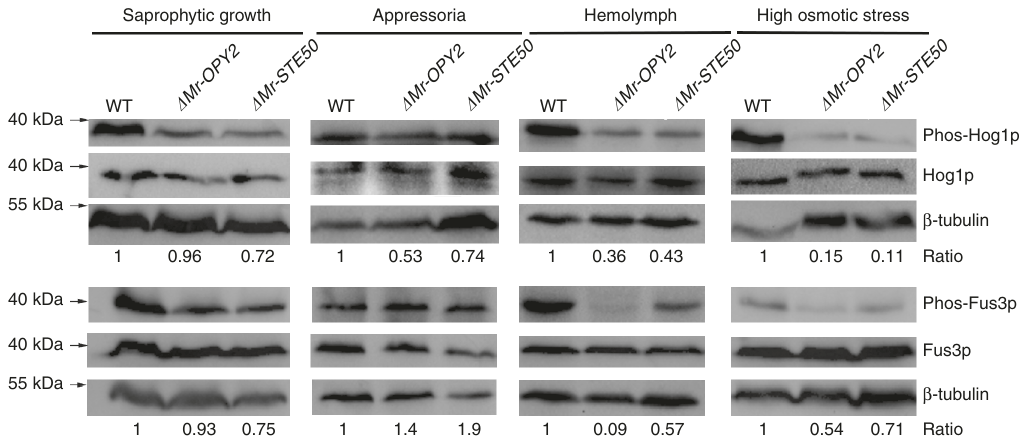
Fig. 6 Regulation of MAPK signaling pathways by Mr-OPY2 and Mr-STE50 during saprophytic growth, pathogenesis and under high osmotic stress. β -Tubulin was used as a loading control. Numbers indicate band intensity for Phos-Fus3p (Phos-Hog1p) relative to total Fus3p (Hog1p). WT values were set to 1. Images are representative of at least three independent experiments for each condition. The uncropped images of the western blots are shown in Supplementary Fig.